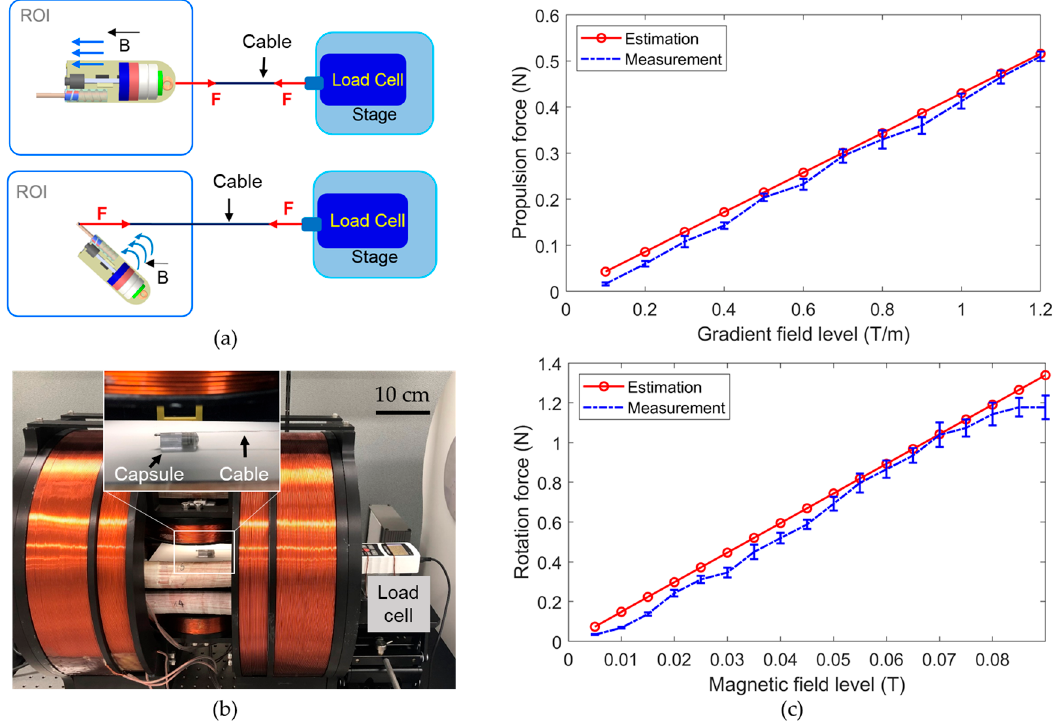
Figure 7. ( a ) Experimental setups for measuring the propulsion force (top) and rotation force (bottom). ( b ) Experimental setup. ( c ) Propulsion force and rotation force of the ACE.